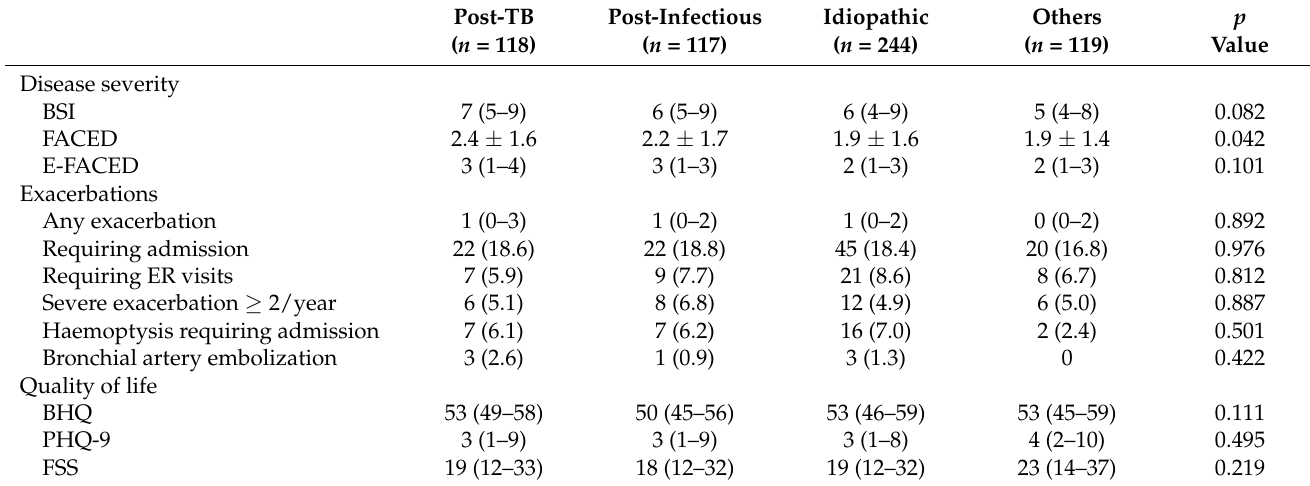
Table 3. Comparison of bronchiectasis severity, exacerbations, and quality of life of patients with bronchiectasis according to their